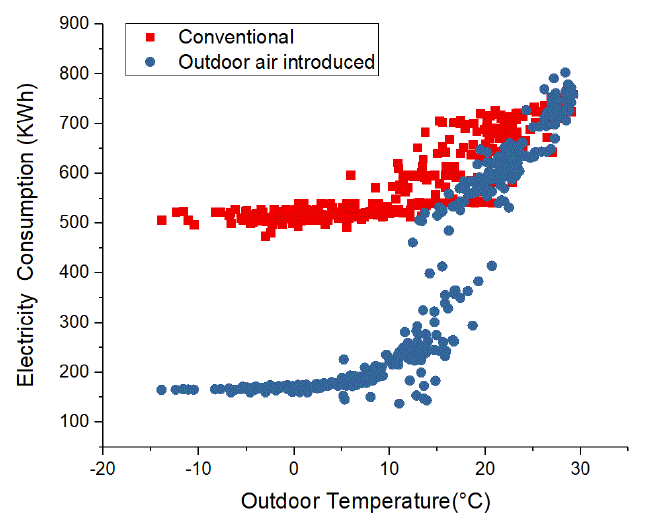
Figure 7. Comparison of the daily electric power consumption according to the daily average outdoor air temperature and the cooling method.